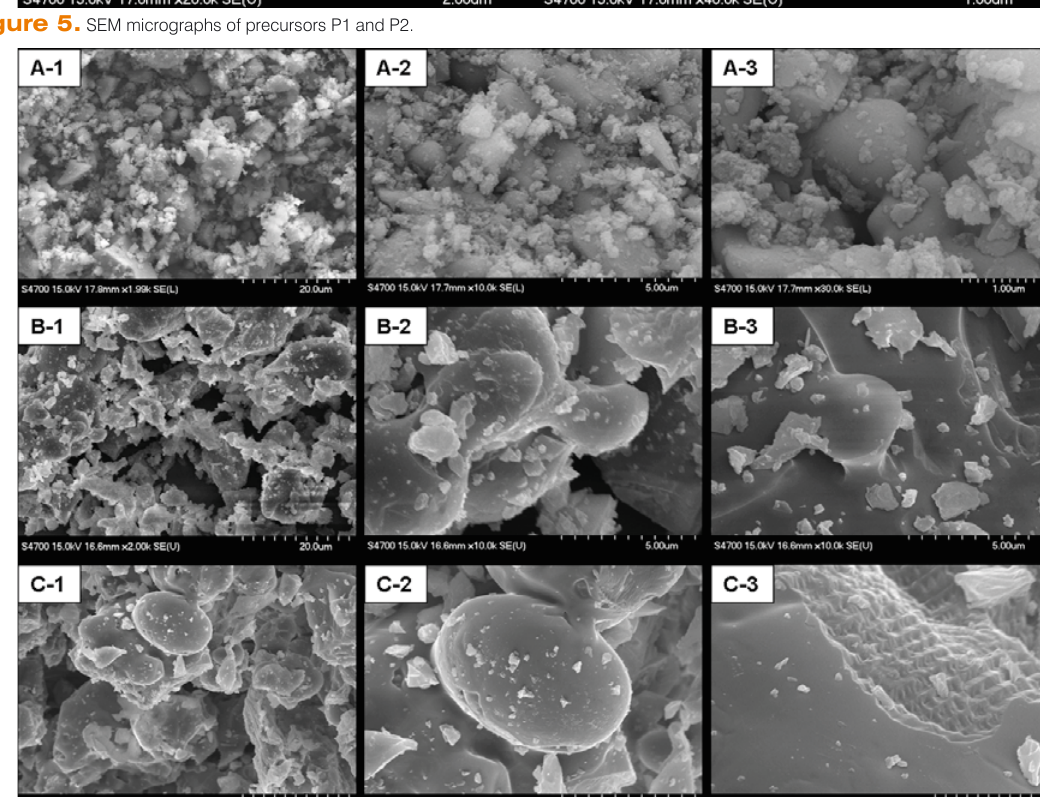
Figure 6. SEM micrographs showing calcinated powders from precursore P1; A – 1 h, B – 3 h and C – 6 h at the temperature